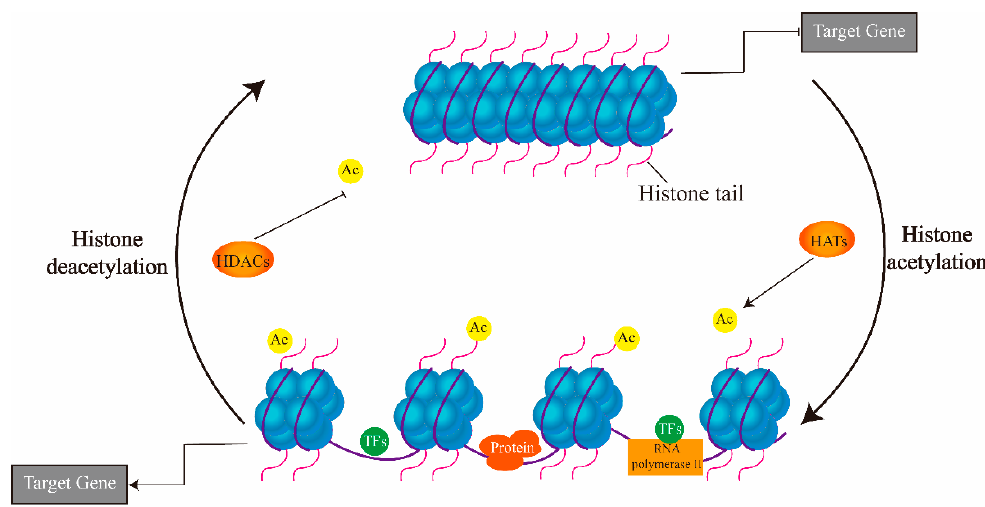
Figure 3. Regulation of histone acetylation by HATs and HDACs.